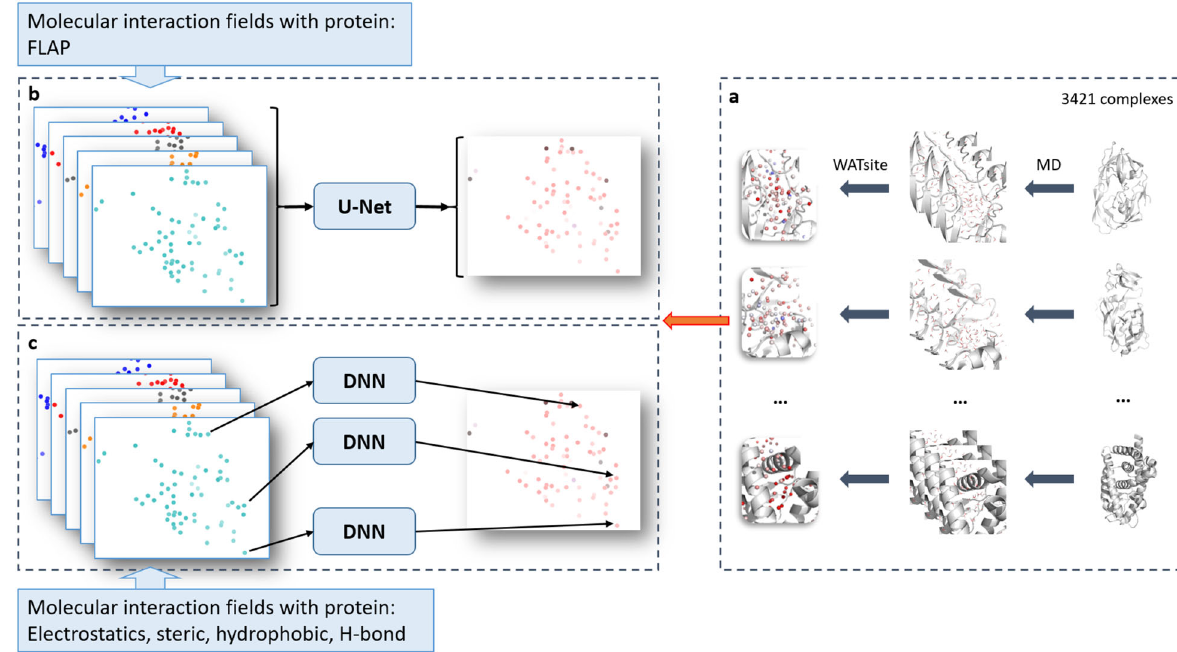
Fig. 3 Overall procedure of prediction of WATsite data using neural networks. a WATsite simulations are used to generate hydration data. Data is used as output layer for training of neural networks. b Direct prediction of complete 3D hydration image using U-Net approach. c Point-wise prediction using simple fully connected neural